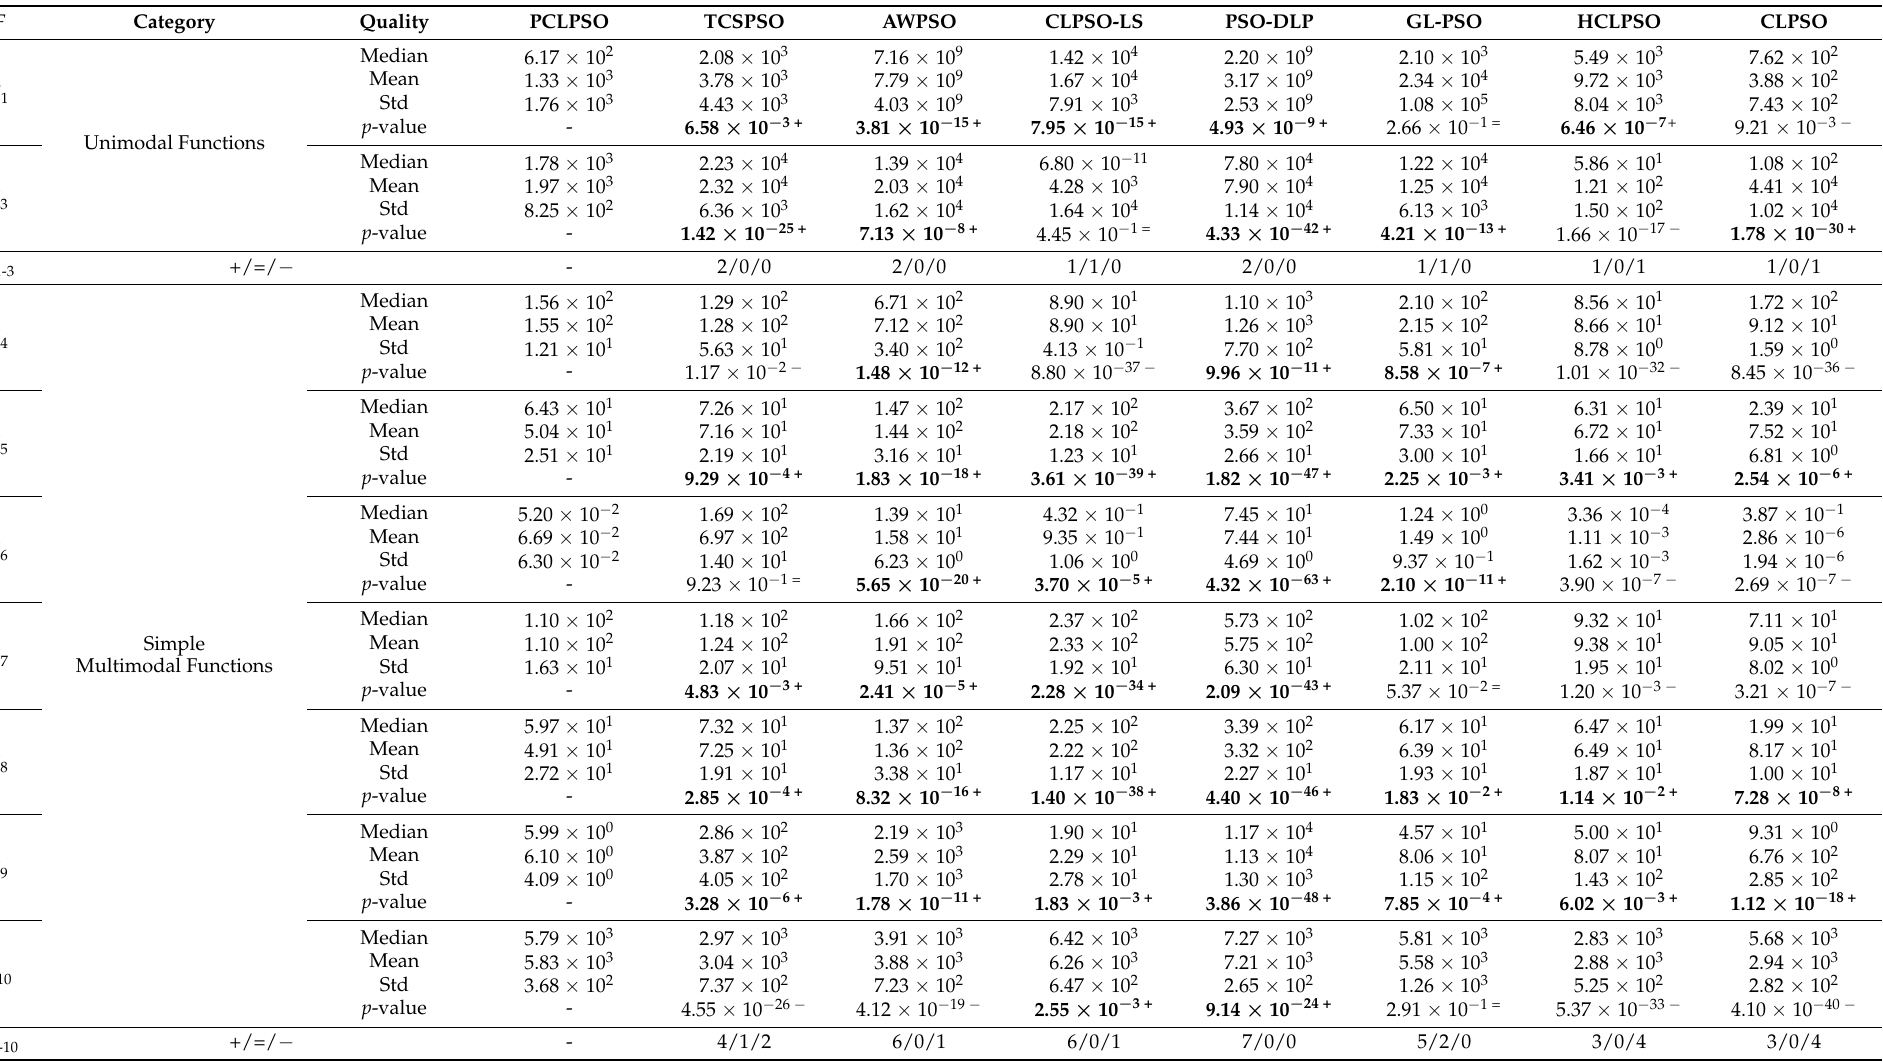
Table 3. Global fitness comparisons between PCLPSO and the seven selected PSO methods on the CEC 2017 benchmark set with the dimensionality set as